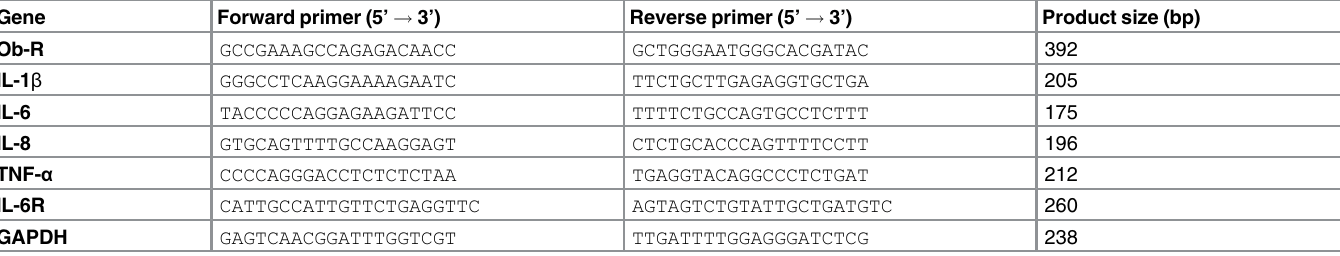
Table 2. List of primers for polymerase chain reaction used in this